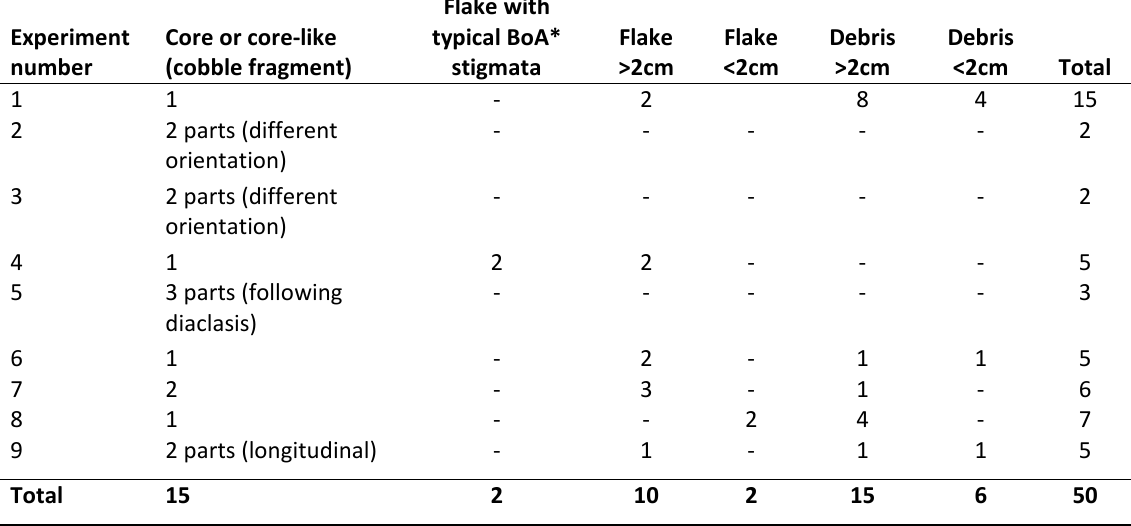
Table 3. Experimentation of bipolar-on-anvil (BoA*) knapping on quartz.